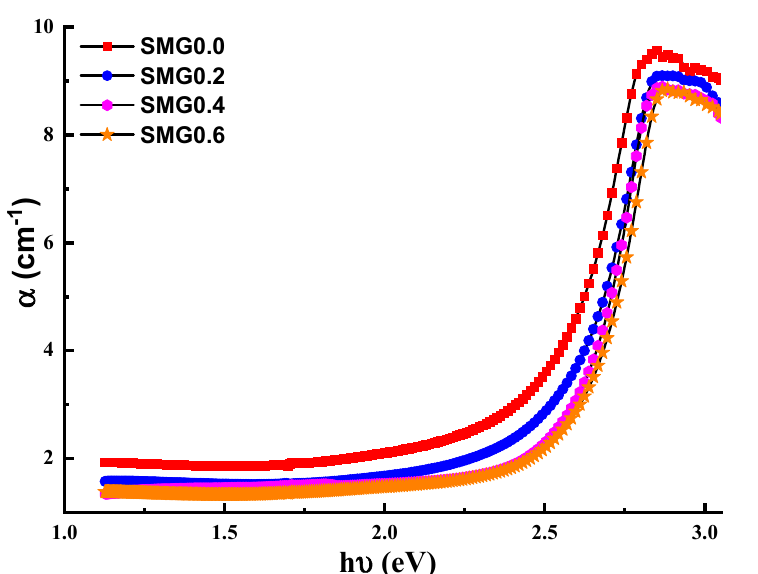
Figure 6. Absorption coefficient ( α ) of glass samples vs. incident energy .